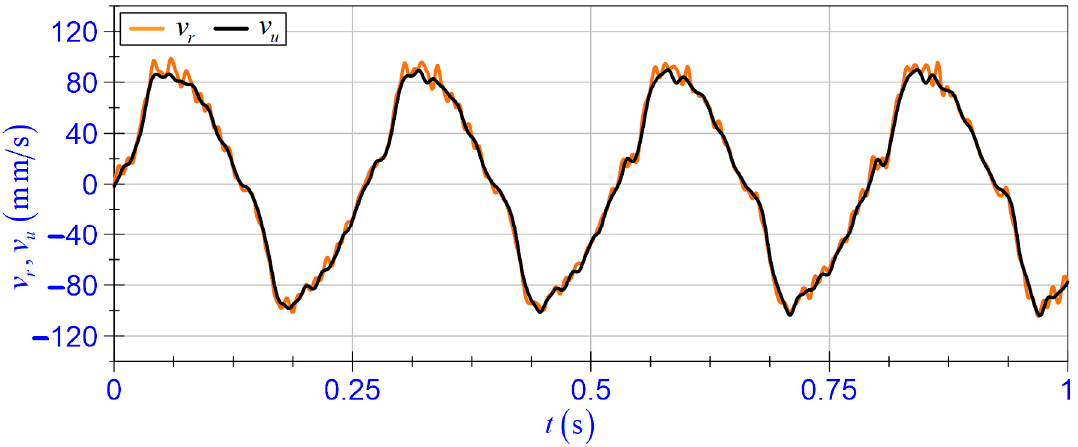
Figure 19. Time patterns of velocity 𝑣 (cid:3045) and 𝑣 (cid:3048) for 𝐶 (cid:2873) and 𝑓 (cid:3053) = 3.8Hz .